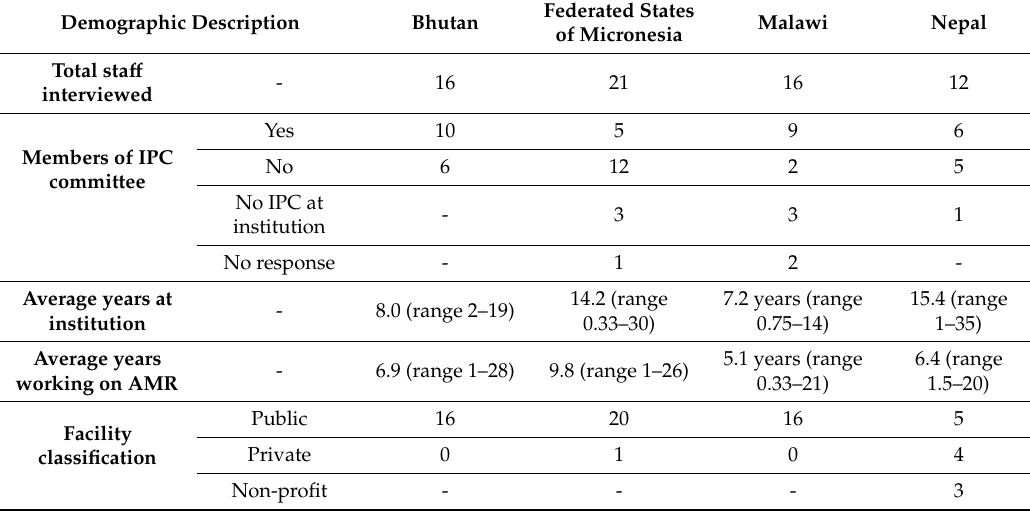
Table 2. Clinical Sta ff Demographics.